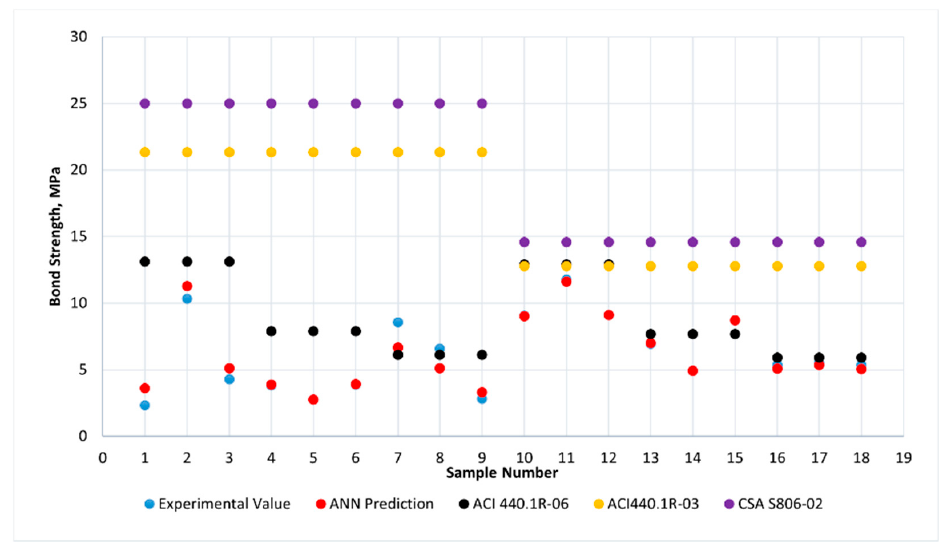
Figure 28. ANN model comparison against other prediction models for all specimens.